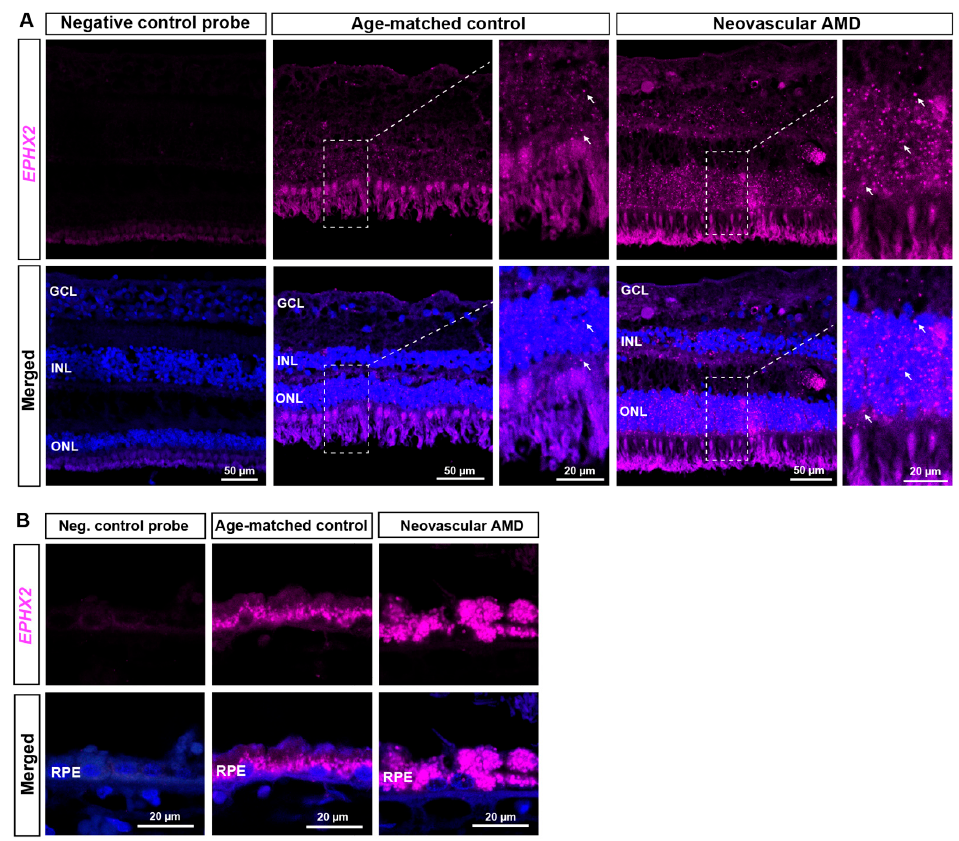
Figure 3. EPHX2 mRNA is highly expressed in the retinal pigment epithelium (RPE) of AMD eyes. Representative images of retinal sections from neovascular AMD (72 y.o., female) and age-matched control eyes (79 y.o., female). EPHX2 encoding sEH is in magenta, and nuclei (DAPI) are in blue. ( A ) EPHX2 mRNA is detected across the retina, including vasculature and photoreceptor cell bodies. Insets show higher magnification images of the indicated areas. EPHX2 mRNA is highly expressed in the photoreceptor cell bodies in the ONL (white arrows). ( B ) Higher magnification images of the RPE in different areas of the same specimens. EPHX2 mRNA is highly expressed in RPE. In neovascular AMD, EPHX2 mRNA signal is increased in the INL, ONL and apical RPE. Bright fluorescent puncta represent positive mRNA signal. Scale bars as indicated. Representative images from n = 2 control and n = 3 nAMD subjects; see also Figure S2.